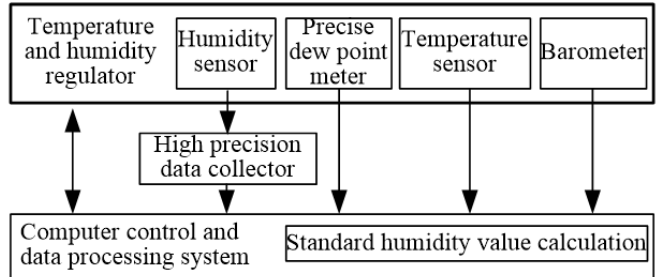
Figure 1. Error experiment of humidity sensor at different temperatures.